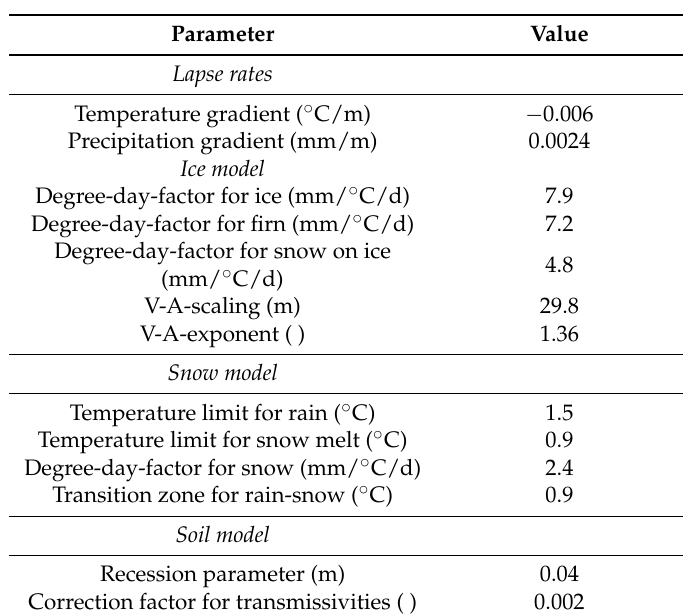
Table 2. Most sensitive model parameters for both catchments with their estimated